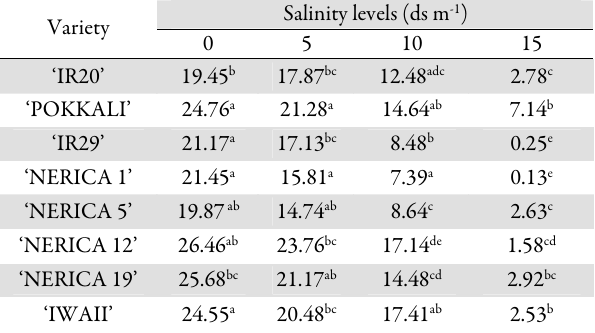
Tab. 2. Effect of Salinity on Speed of Germination (SG) of different rice